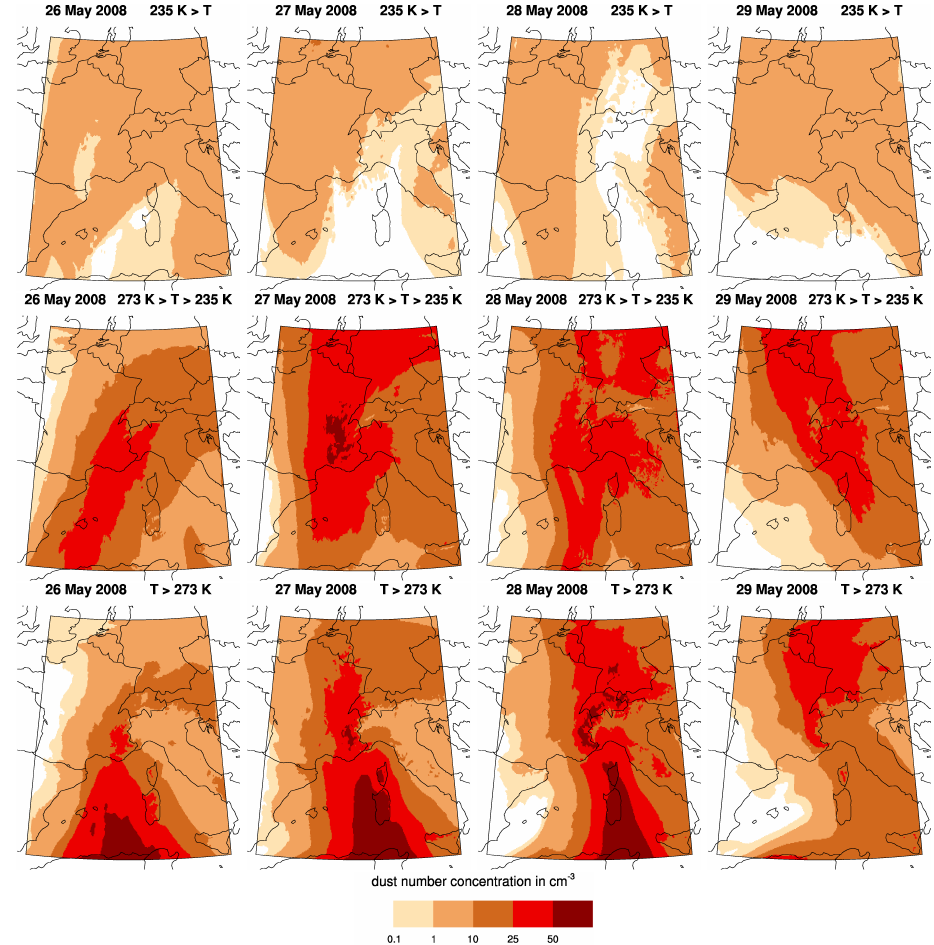
Fig. 6. Simulated daily means of dust number concentrations for atmospheric layers below freezing level (bottom row), layers favorable of heterogeneous freezing (middle row), and layers favorable of homogeneous freezing (top row) for 26–29 May 2008 (columns).